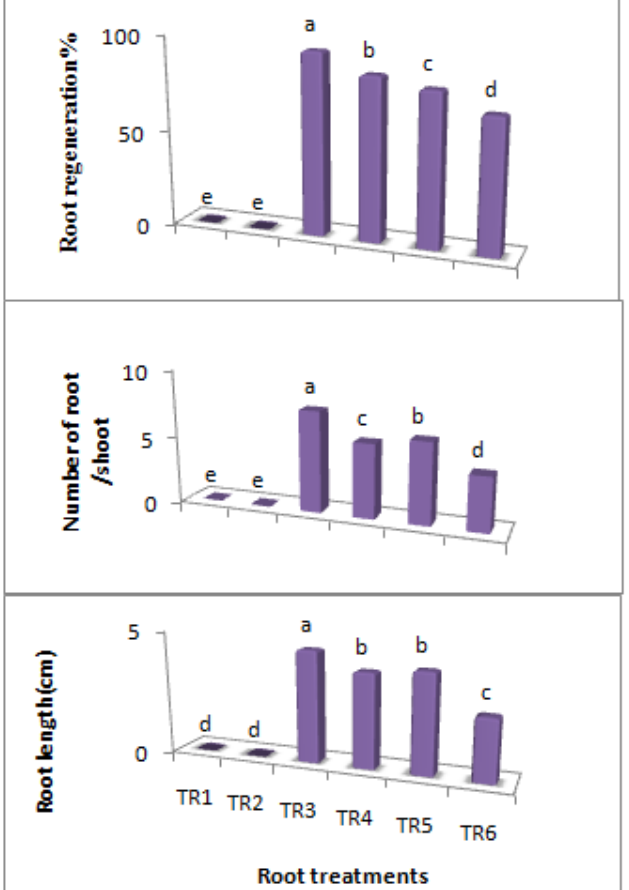
Figure 6. Effects of MS medium strength and IBA concentration on rooting of in vitro regenerated shoots of C.asiatica. n = 4 (TR1 = MS without IBA; TR2 = ½ MS without IBA; TR3 = MS + IBA 0.5 mg/L; TR4 = ½ MS + IBA 0.5 mg/L;